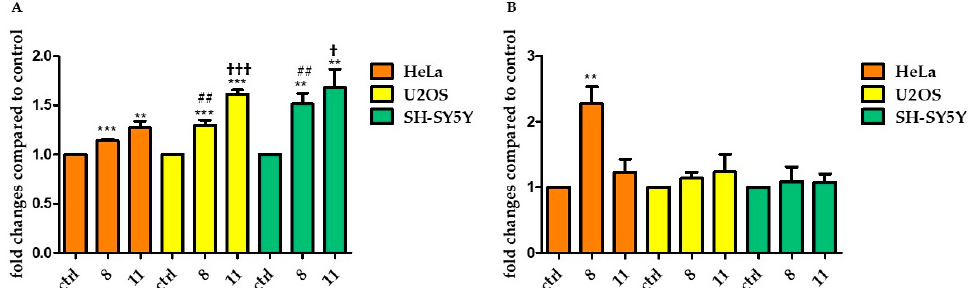
Figure 5. Induction of intracellular ROS in HeLa, U2OS, and SH-SY5Y cells treated with 8 and 11 under physiological conditions at 37 °C for 1 h ( A ) and 48 h ( B ). Data represent the means (SDs) of three determinations. *** indicates statistically significant differences at p < 0.0001, ** at p < 0.001 respectively, compared with control (0.1% DMSO). ## p < 0.001 relative to HeLa cells treated with 8 ; ††† p < 0.0001 and † p < 0.05 relative to HeLa cells treated with